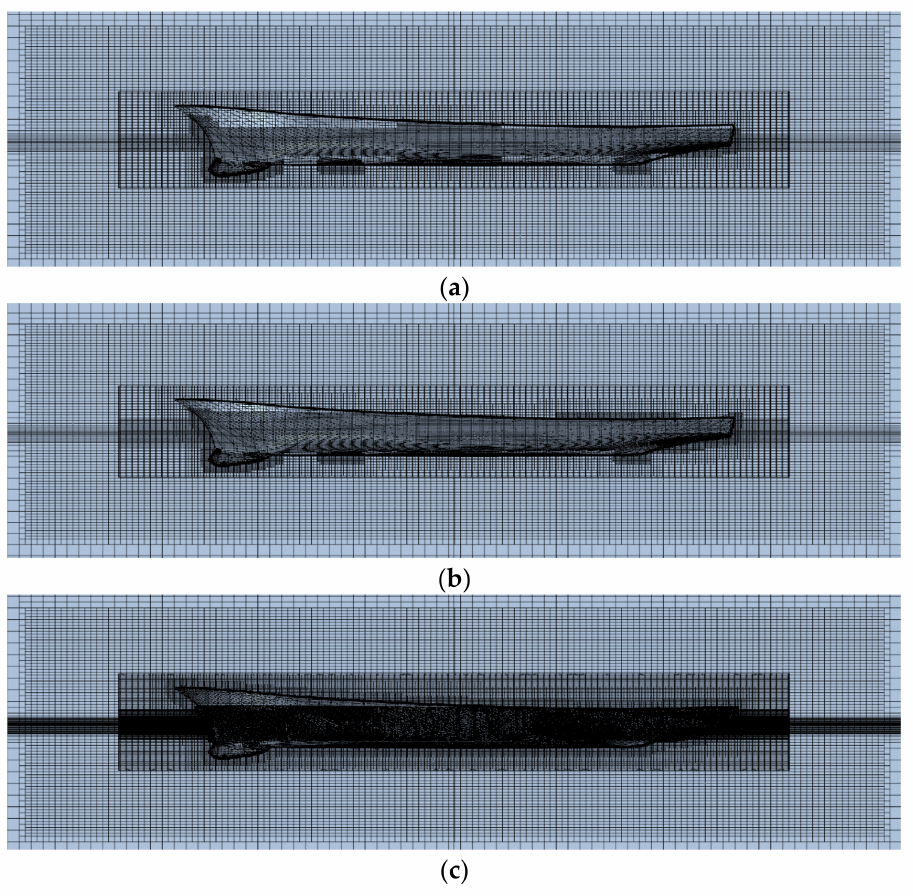
Figure 7. The generated meshes for the damaged DTMB 5415 ship. ( a ) Coarse mesh A; ( b ) Medium mesh B; ( c ) Fine mesh